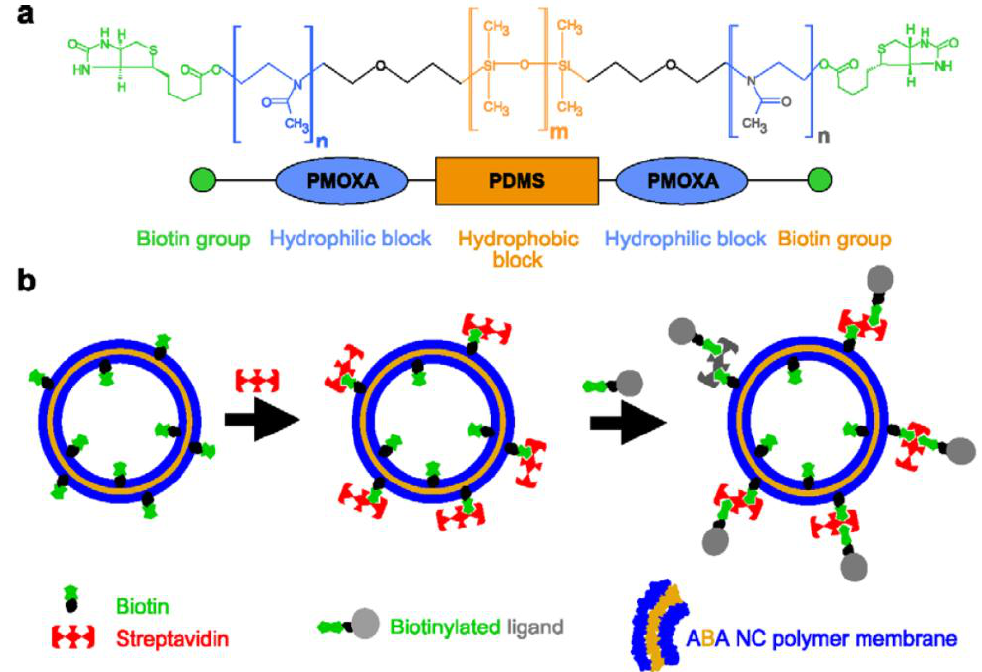
Figure 2. Surface-modification of polymersomes exploiting biotin-streptavidin